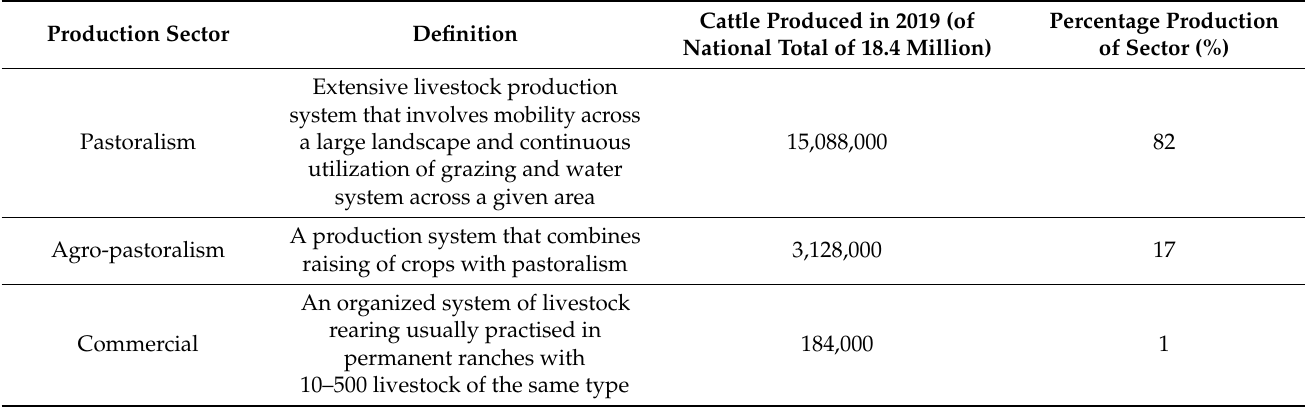
Table 1. Demographic details of Nigerian national cattle herd, 2019. Data from